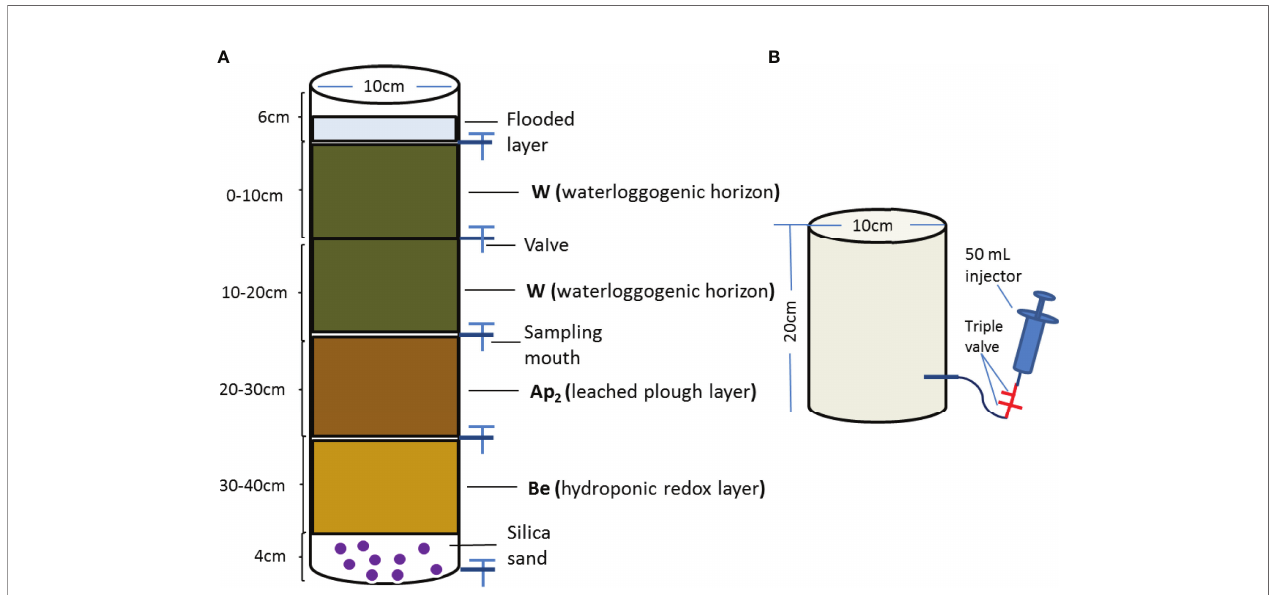
FIGURE 1 | (A) Diagram of soil column experimental design (Column height: 50cm, Inner diameter: 10cm). A 3% w/w different pyrolysis wheat straw biochar was mixed with 0-10cm soil layer (referred as to soil to biochar) along with an identical fertilizer level (i.e. CK, Control treatment without biochar and fertilizer; F, Only fertilizer added; FBC300, 300°C biochar combined with fertilizer; FBC500, 500°C biochar combined with fertilizer; FBC700, 700°C biochar combined with fertilizer). Silica sands were placed at the bottom to keep column aeration, and unwoven was twined at inward sampling mouth to against blocking (20). (B) Sketch drawing of static closed chamber sampling gas from soil